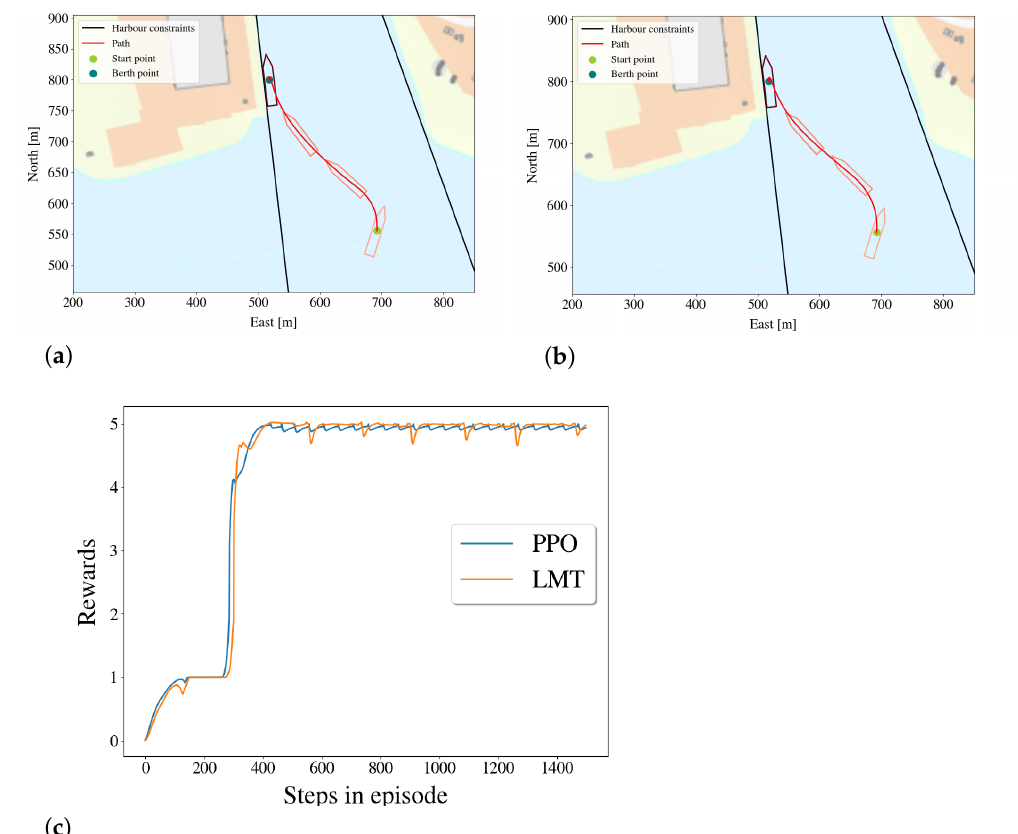
Figure 11. ( a ) A successful run by the LMT OFS 312, ( b ) a sucussefull run by the PPO-policy, and ( c ) the LMT’s and PPO-policy’s rewards for their respective runs with the same starting points.